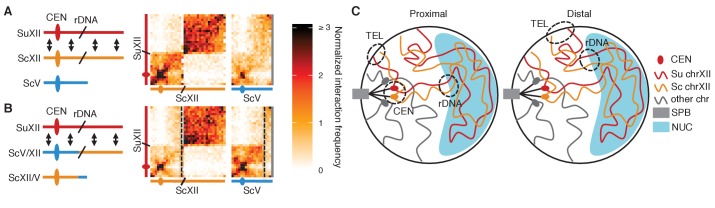
rDNA-carrying chromosomes interact preferentially due to shared tethering.(A and B) Schematics and contact maps of rDNA-carrying chromosomes S. uvarum chromosome XII (SuXII) and S. cerevisiae chromosome XII (ScXII), and S. cerevisiae chromosome V (ScV), in wild-type S. cerevisiae x S. uvarum hybrids (A) and a strain with a translocation between ScXII and ScV (B), both in exponential growth. Ovals indicate centromeres and slanted lines indicate the rDNA arrays. Double-headed arrows indicate enhanced interactions. Dashed lines in the contact maps indicate the translocation breakpoints. (C) Schematic of how the rDNA-carrying chromosomes S. cerevisiae (Sc) chrXII and S. uvarum (Su) chrXII preferentially interact due to shared tethering. The proximal halves (left diagram) of the chromosomes, which contain the centromeres (CEN), are tethered at the spindle pole body (SPB) at their centromeres, at the periphery at their telomeres (TEL), and at the nucleolus (NUC) at their rDNA arrays (rDNA). The distal halves (right diagram) are tethered at their telomeres and rDNA, but not their centromeres. These combinations of tethering points are not found in other chromosomes (shown in grey). Su, S. uvarum; Sc, S. cerevisiae.